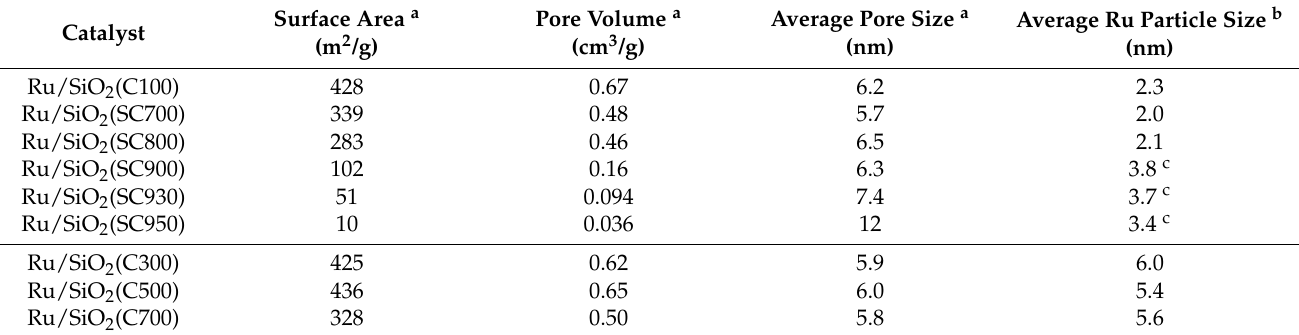
Table 1. The physicochemical properties of the Ru/SiO 2 catalysts.